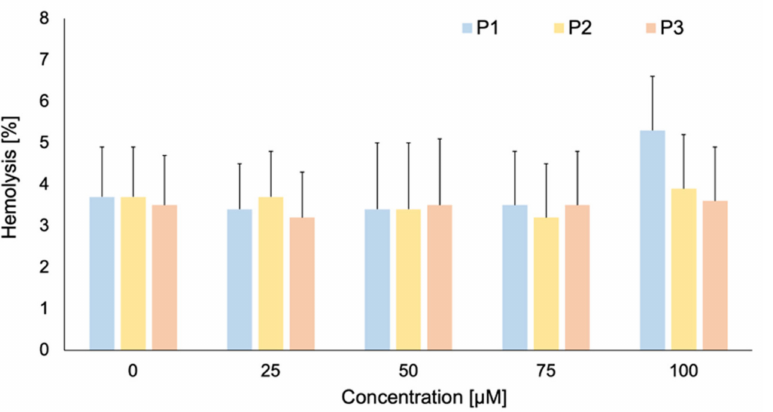
Figure 3. The percentage of hemolyzed red blood cells (RBCs) under the influence of P1, P2, and P3 liposomal formulation at 10–100 µ M